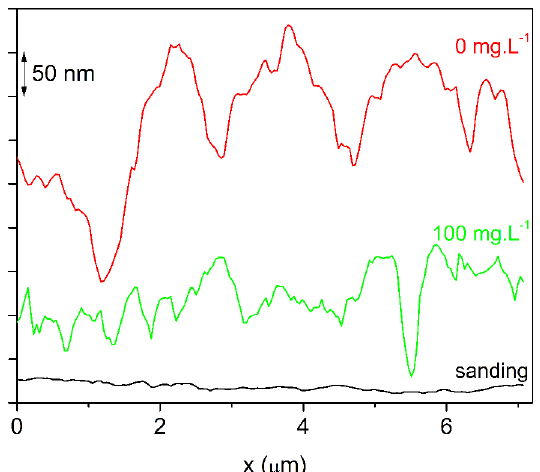
Figure 11. Surface roughness profile across the sample diagonals measured with AFM.